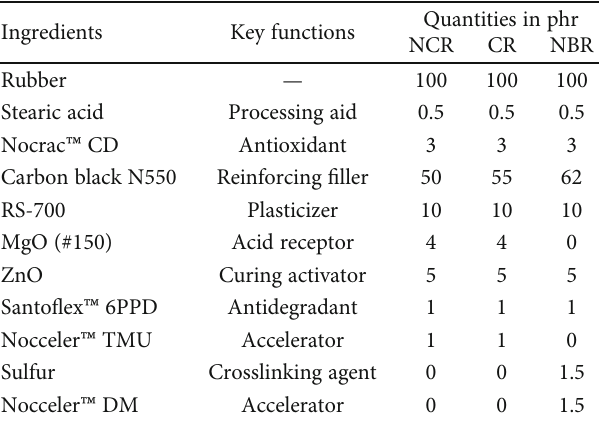
Table 1: Basic compounding formulations used for acrylonitrile- chloroprene rubber (NCR), chloroprene rubber (CR), and nitrile rubber